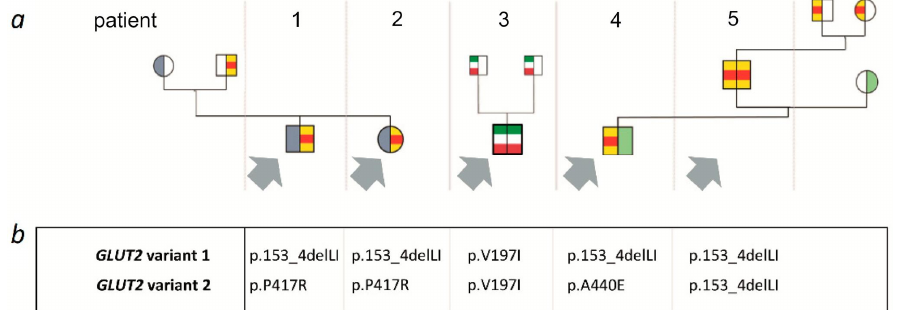
Figure 1. ( a ) Pedigree of affected families; ( b ) GLUT2 ( SLC2A2 ) genotype in patients